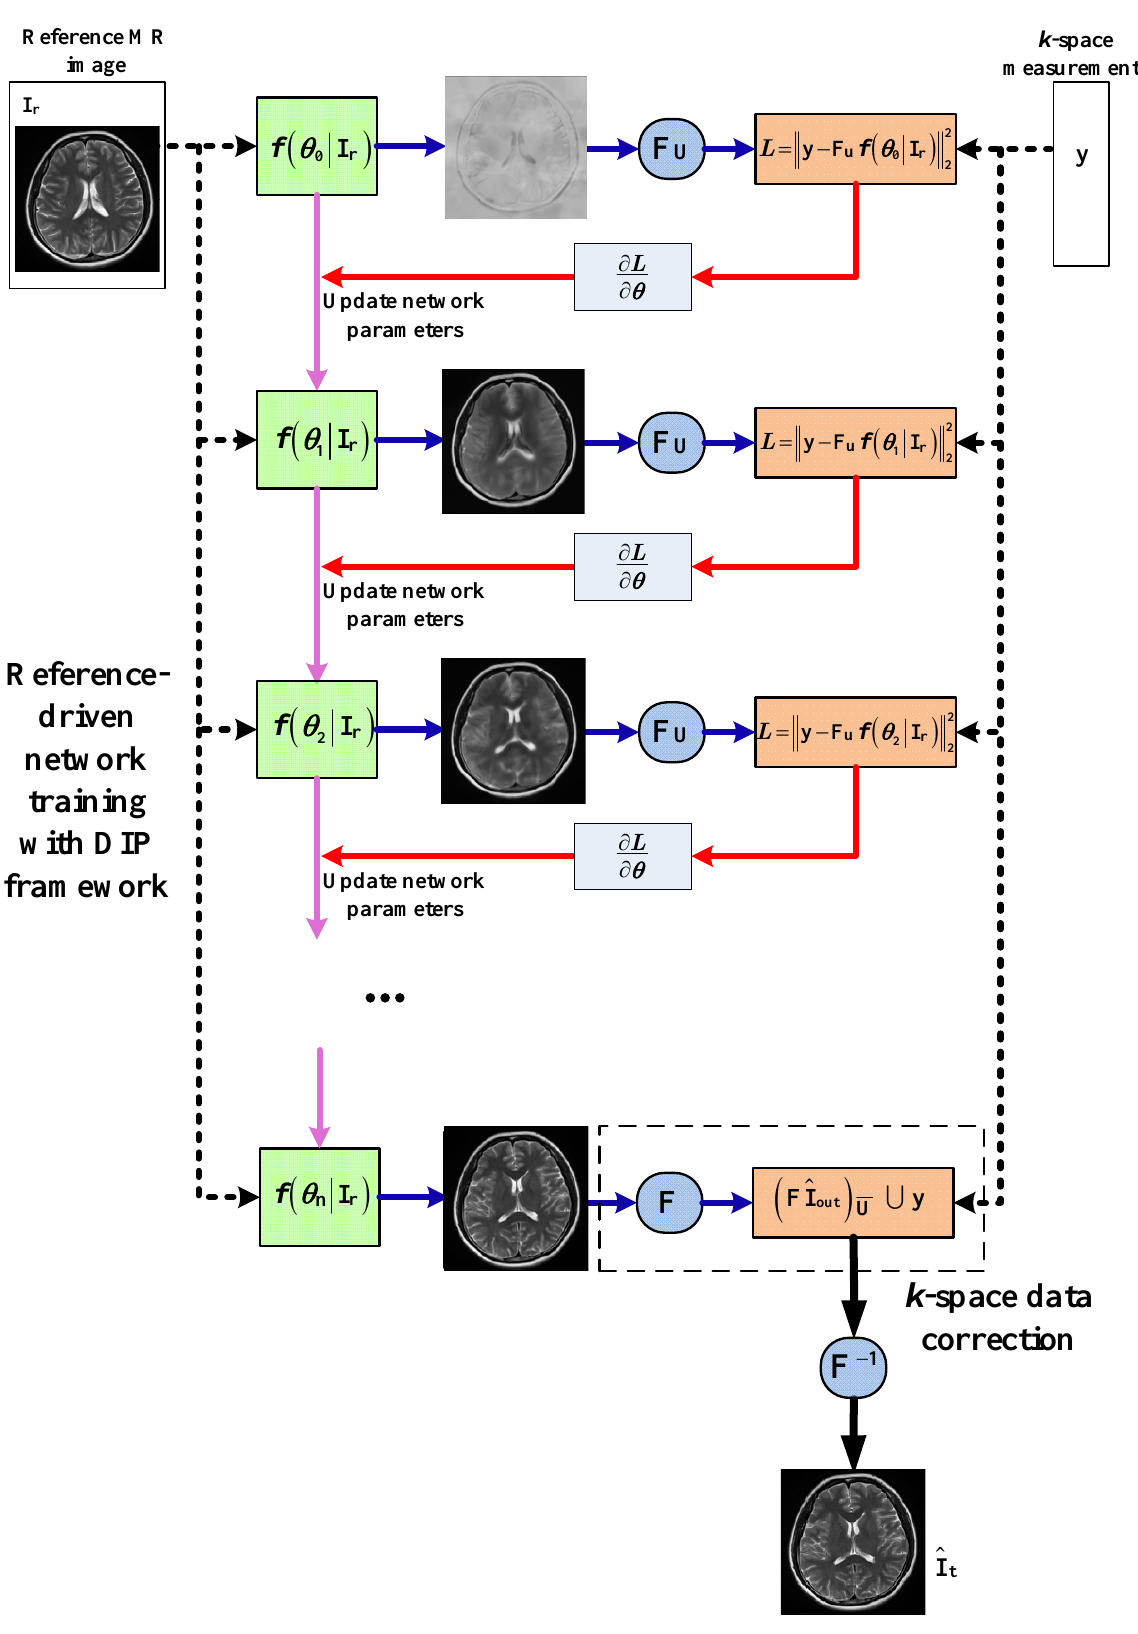
Figure 1. Overview of our proposed method. DIP, Deep Image